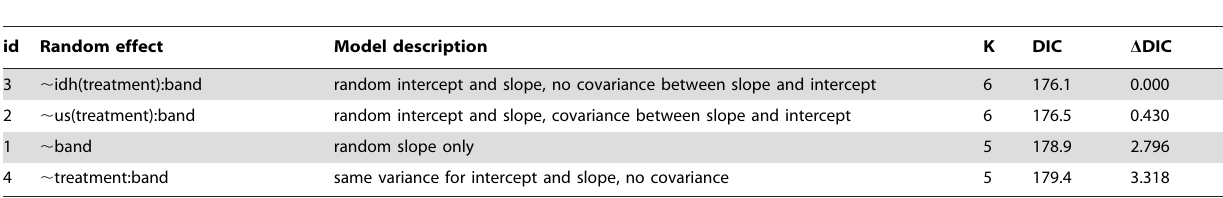
Table 1. Comparison of a priori candidate models of individual differences in corticosterone responsiveness.